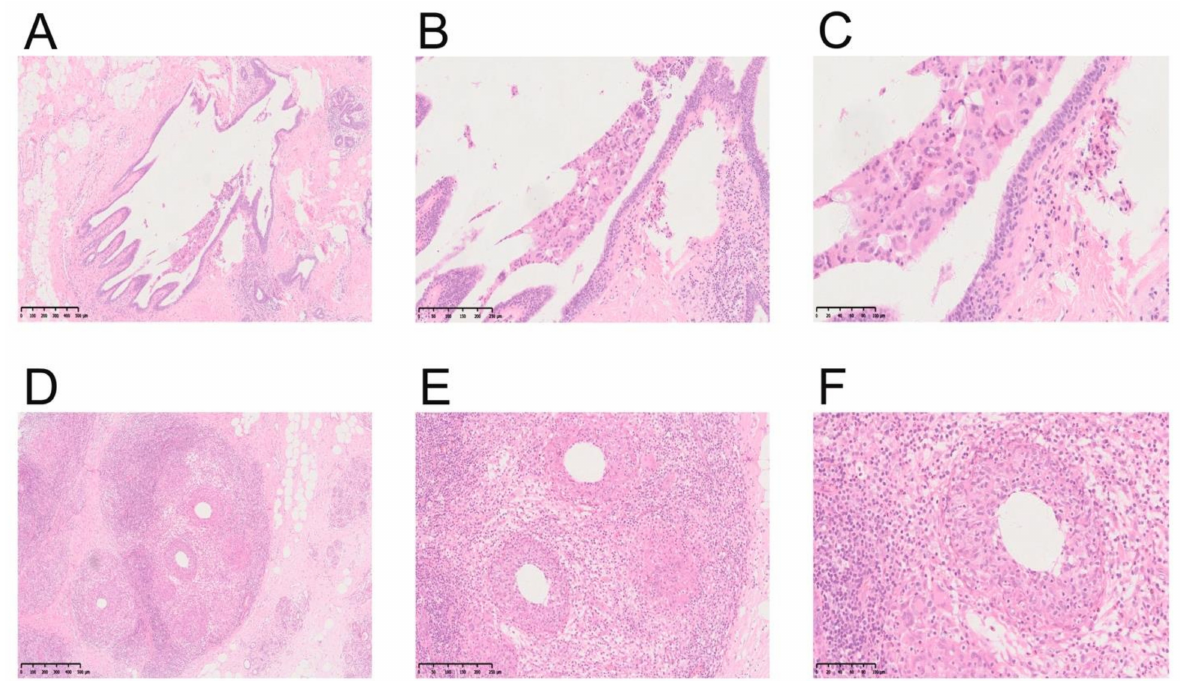
Figure 2. Representative illustrations of MDE and GLM. ( A ) Low-power magnification of MDE (HE, × 40). ( B ) Medium-power magnification of MDE (HE, × 100). ( C ) High-power magnification of MDE (HE, × 200). ( D ) Low-power magnification of GLM (HE, × 40). ( E ) Medium-power magnification of GLM (HE, × 100). ( F ) High-power magnification of GLM (HE, ×